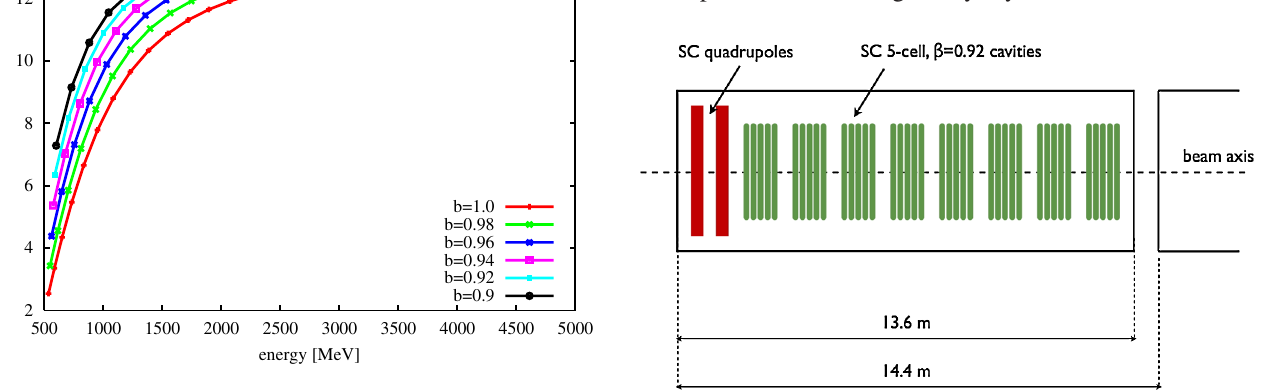
FIG. 2. (Color) Real-estate gradients for different geometric betas in the high-energy section of the SPL (corrected for lower fields at lower betas).